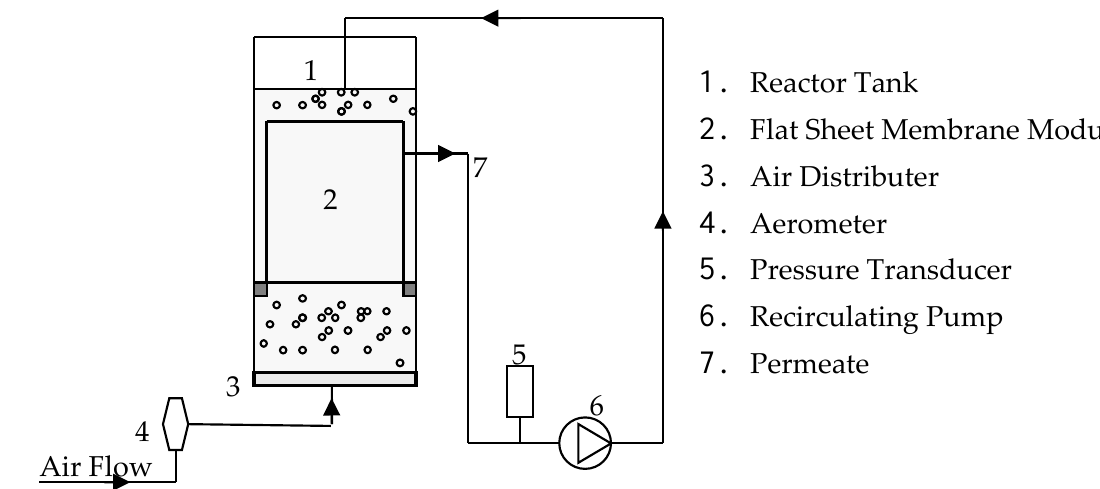
Figure 2. Schematic diagram of the experimental setup. Before each experiment, the membrane was tested for its hydraulic resistance. The membrane cleaning procedure involved three stages of cleaning. The membrane was first cleaned with tap water. It was then placed in a specially designed holding unit attached to the shaker for an hour at 120 rpm and cleaned with tap water again. Finally, the membrane was submerged in a chemical solution (3% w / w sodium hypochlorite) for three hours. state